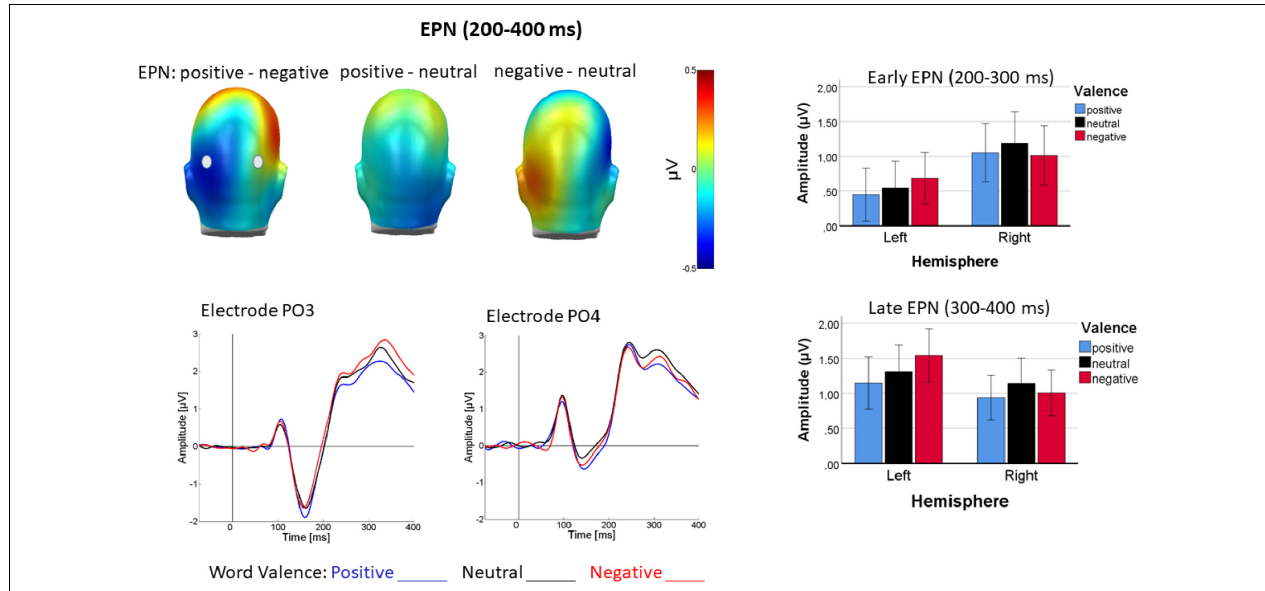
FIGURE 6 | Top left shows difference topographies for positive minus negative, positive minus neutral and negative minus neutral words averaged across a time window of 200–400 ms (EPN1 and EPN2). Bottom left: ERP time course for positive (blue), neutral (black), and negative (red) words at representative sensors PO3 (left) and PO4 (right) . Right panel: Bar charts of average activity in left and right occipital sensor groups elicited by the different word valences from 200 to 300 ms (top) and 300 to 400 ms (bottom). Error bars are standard errors.